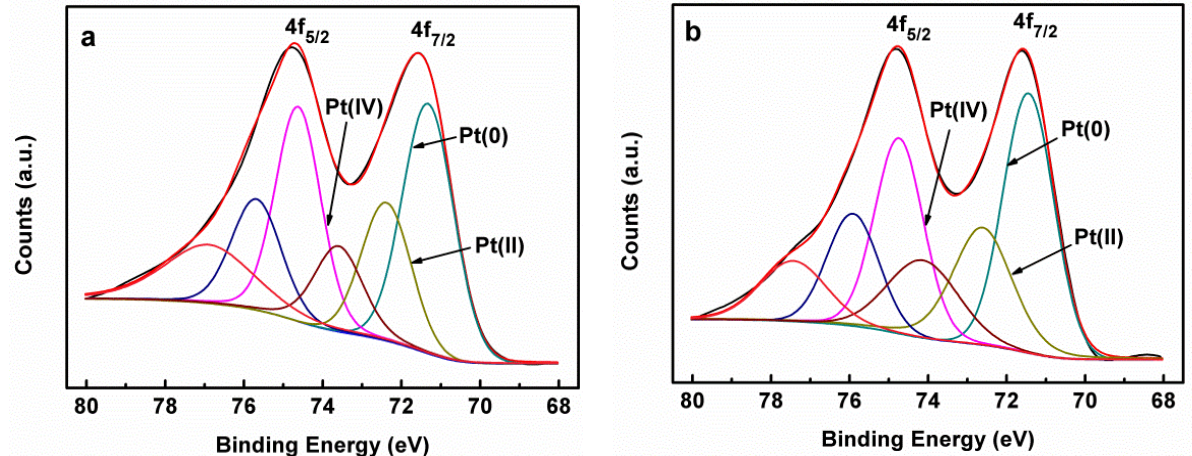
Figure 3. Lorentzian curves of Pt 4f XPS spectra of the Pt-Ni catalysts